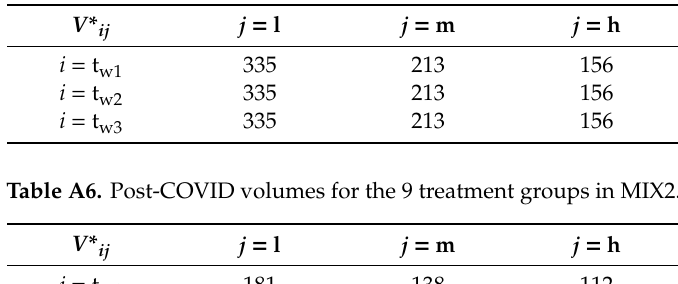
Table A5. Pre-COVID volumes for the 9 treatment groups in MIX2.